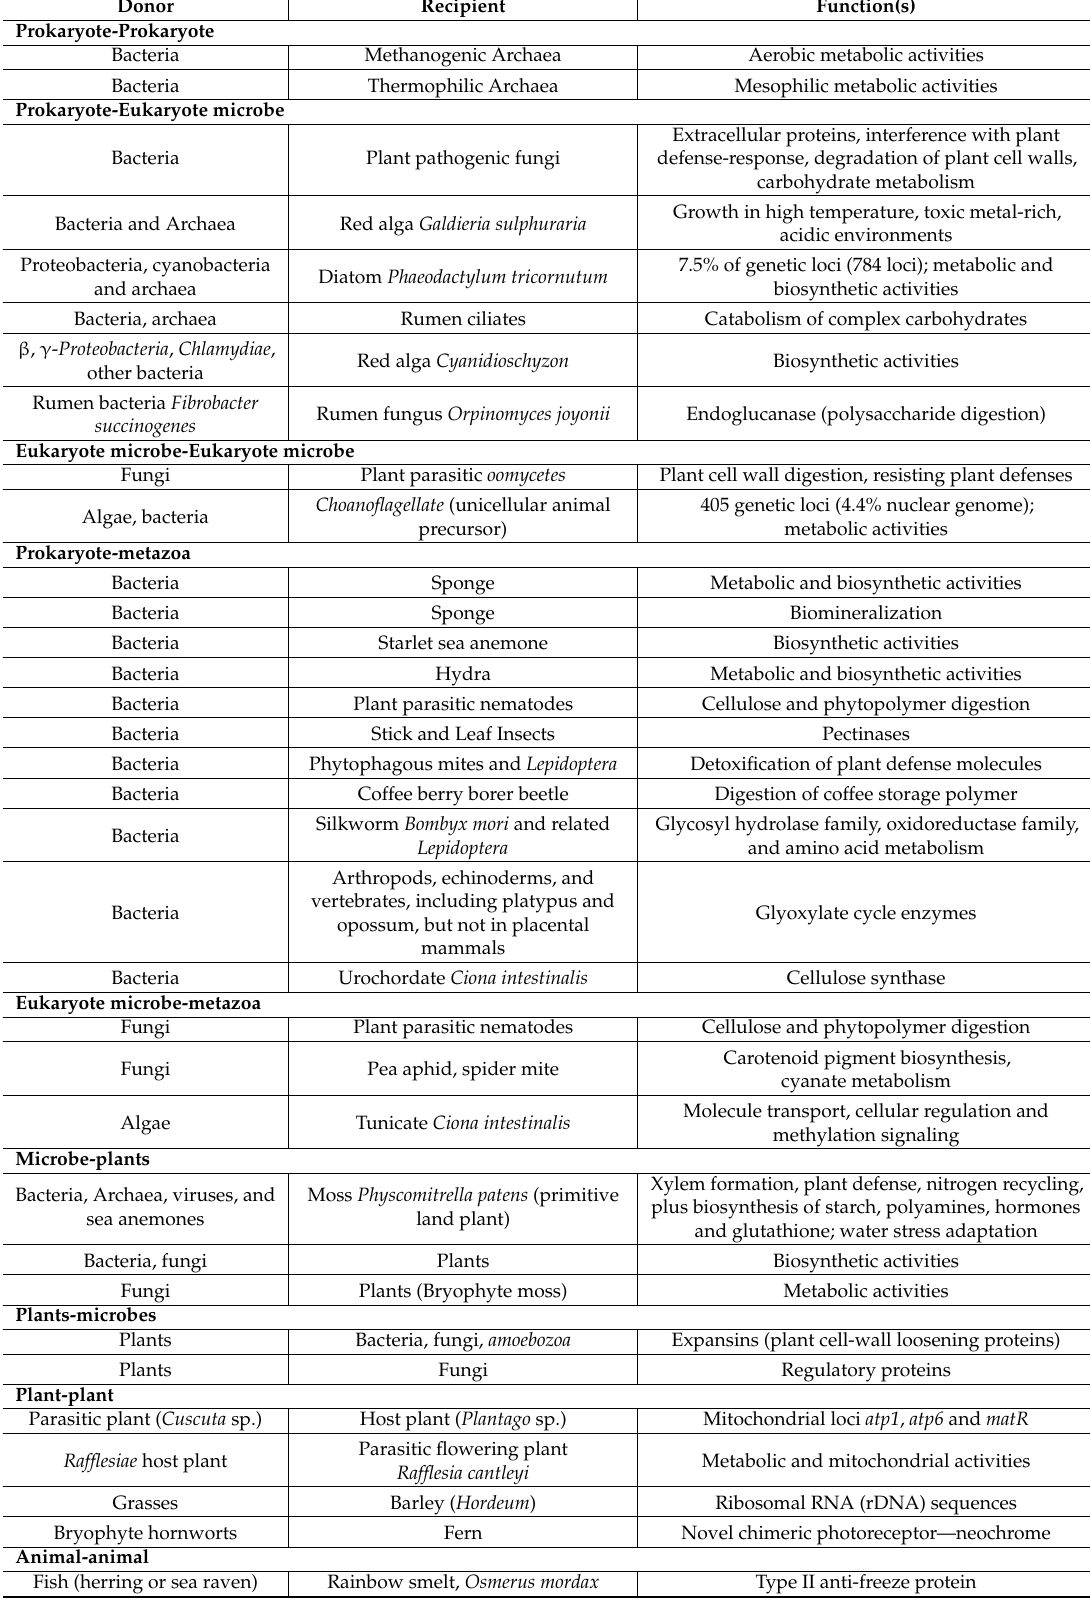
Table 7. Selected examples of inter-phylum adaptive horizontal DNA transfers based on genomic